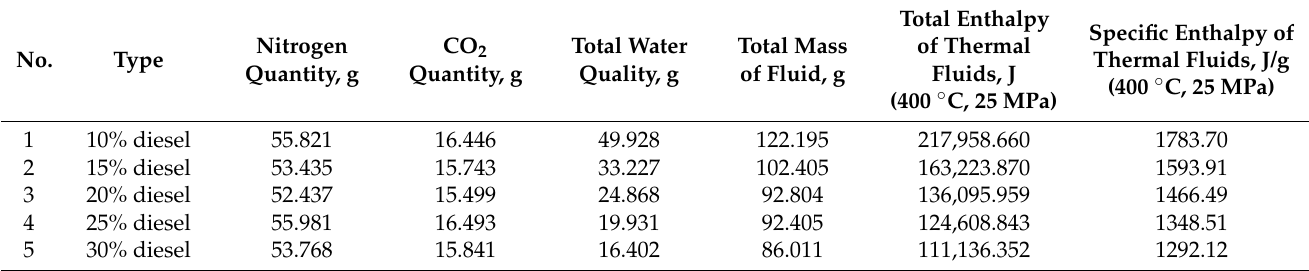
Table 9. Enthalpy of supercritical multi-thermal fluids generated by supercritical water–diesel reaction under different oil–water ratios.